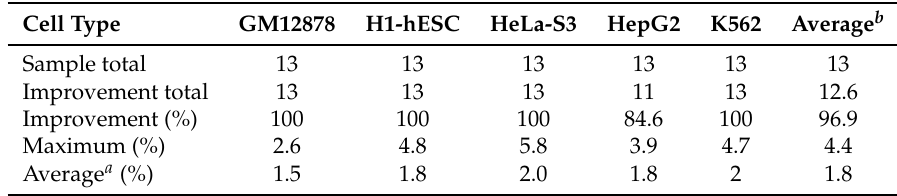
Figure 4. AUCs of cross-cell-type prediction by DANN_TF and the baseline method and that of supervised prediction by the baseline method. Scatter plots depicting the AUC comparison between ( a ) DANN_TF and the baseline method and that ( b ) between DANN_TF and supervised prediction. Scatter plots depicting the F1 comparison between ( c ) DANN_TF and the baseline method and that between ( d ) DANN_TF and supervised prediction. Box plots depicting ( e ) the AUC comparison and ( f ) the F1 comparison between DANN_TF, the baseline method and supervised prediction. Table 2. Details of the comparison between DANN_TF and the baseline method for cross-cell-type prediction. (Average a denotes the average improvement, Average b denotes the micro average over the total number of